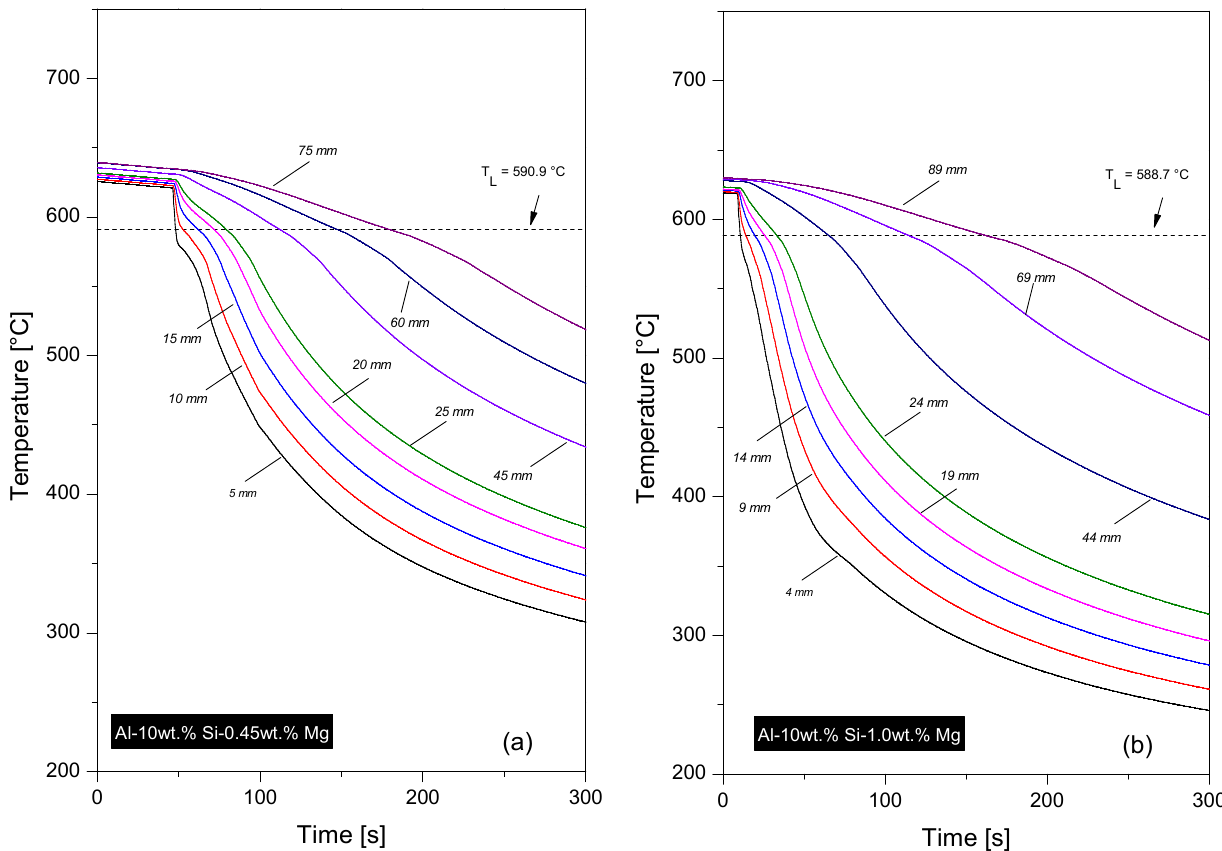
Figure 1. Temperature x time profiles registered at different points along the length of the casting during solidification of the ( a ) Al-10 wt.% Si-0.45 wt.% Mg and ( b ) Al-10 wt.% Si-1 wt.% Mg alloys. The distances marked within the graphics represent the positions from the metal/mold interface.